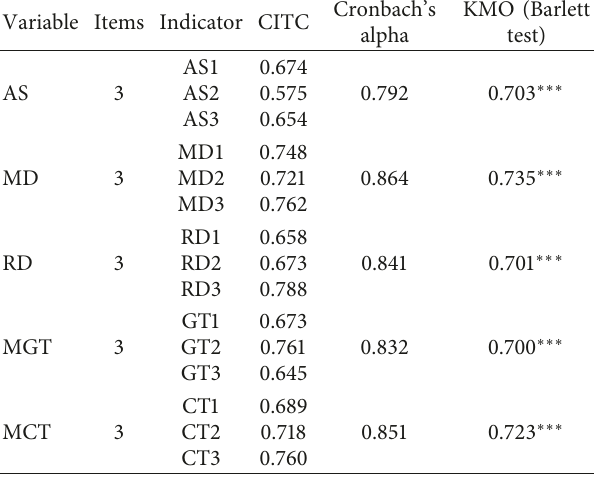
Table 2: Reliability test.